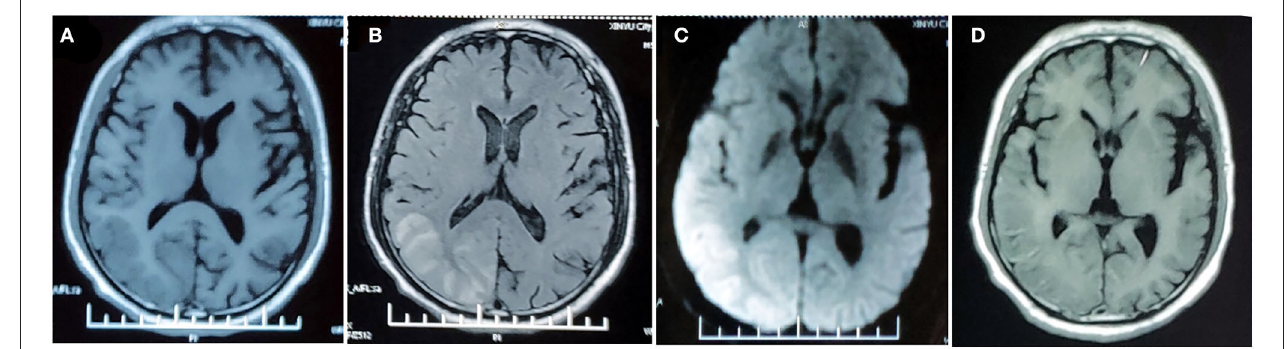
FIGURE 1 | MRI findings in the first prolonged attack. MRI performed 5 days after attack onset demonstrates right temporo-occipital lobe hypointensity on T1-weighted image (A) and hyperintensity on T2-FLAIR image (B) with restricted diffusion on DWI (C) . MRI performed 4 weeks after symptom onset demonstrated right temporal–occipital cortical hyperintensity on T1-weighted images (D) .